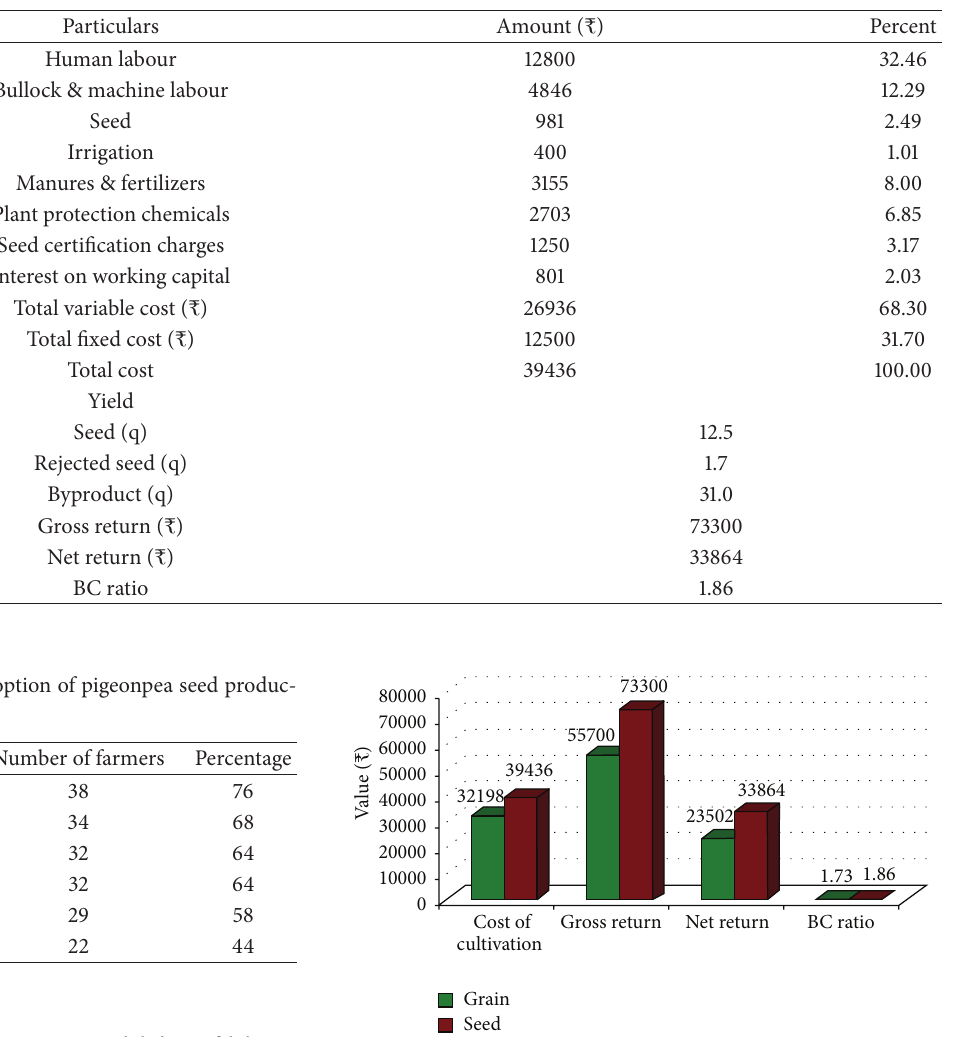
Table 4: Costs and returns in certified seed production of pigeonpea ( s /ha). Sl.